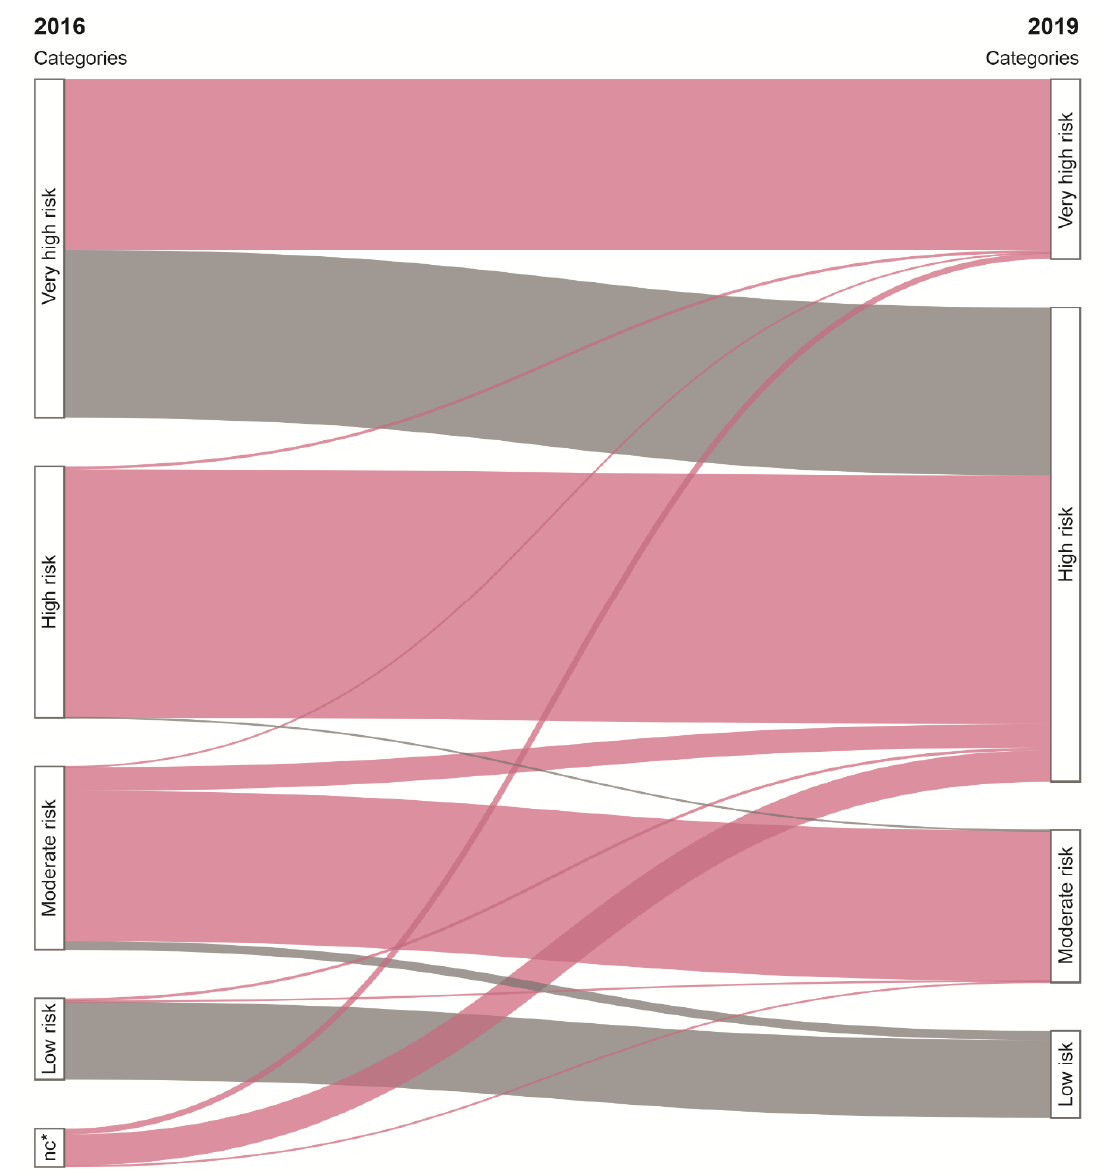
Figure 2. Impact of the 2019 ESC / EAS guideline on CV risk classification and LDL-C target values. Flows represent patients’ classification according to the 2016 and 2019 guidelines; the size of each flow is in proportion to the number of patients. Colors indicate changes in LDL-C target values: red: decrease of LDL-C target value, grey: no change of LDL-C target value. * no classification.